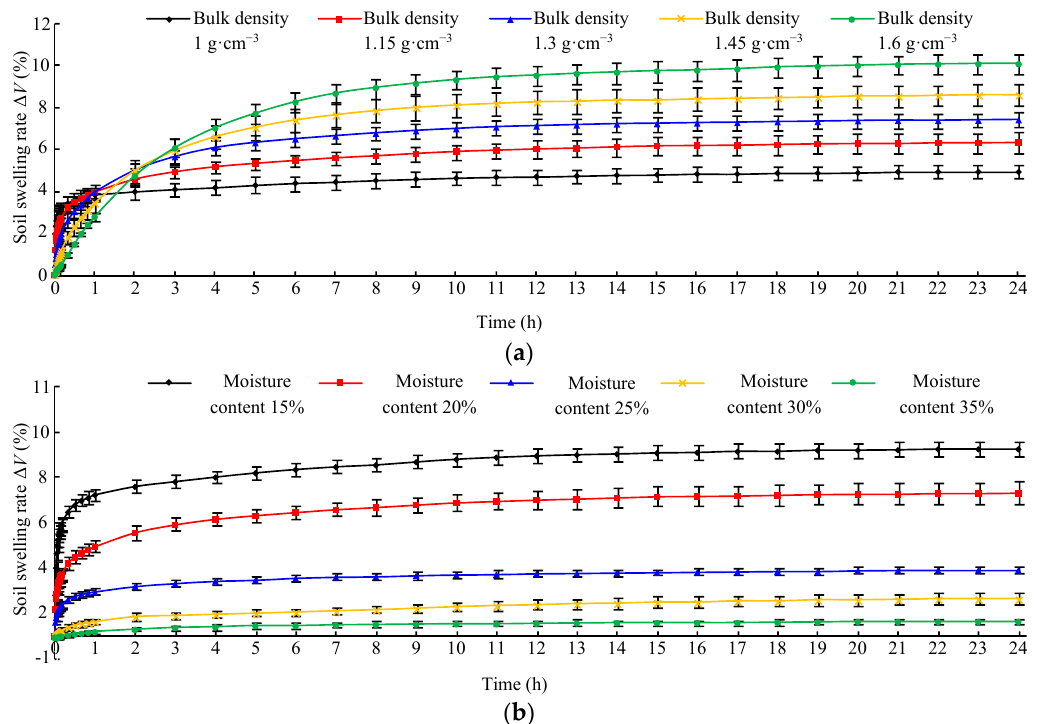
Figure 6. Relation curves of swelling rate of paddy soil with time: ( a ) variation of paddy soil in bulk density, and ( b ) variation of paddy soil in moisture content.